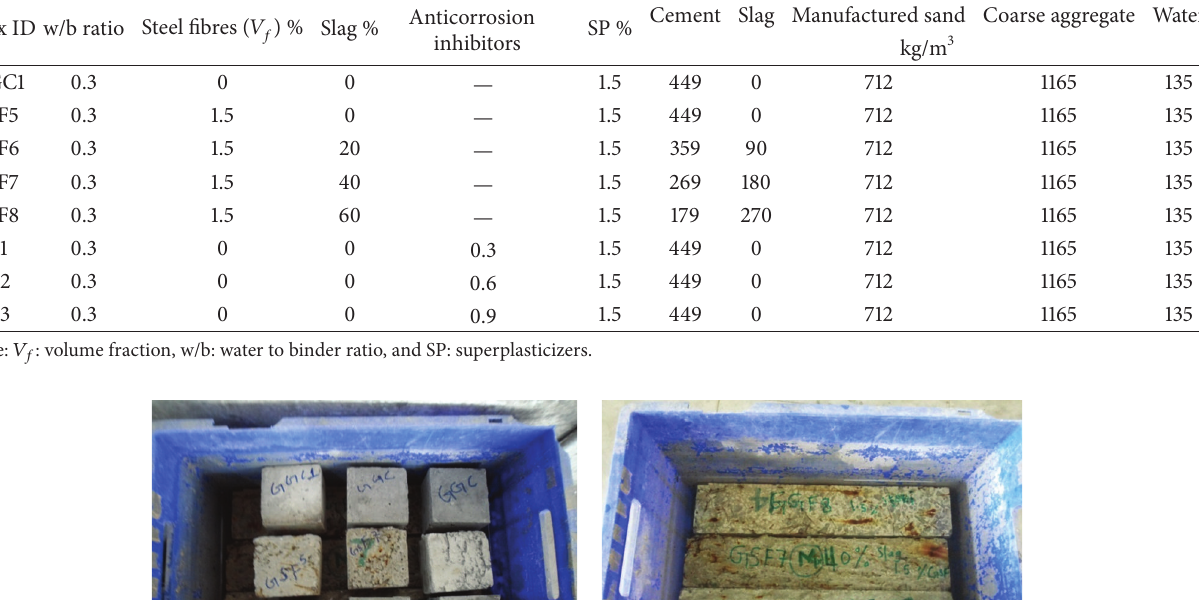
Table 1: Various concrete mixture proportions used in the study.